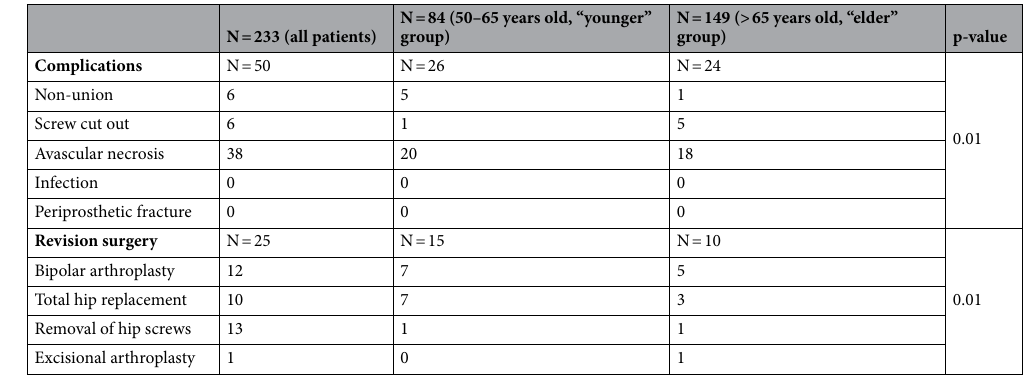
Table 2. Fracture complications and revision surgery.